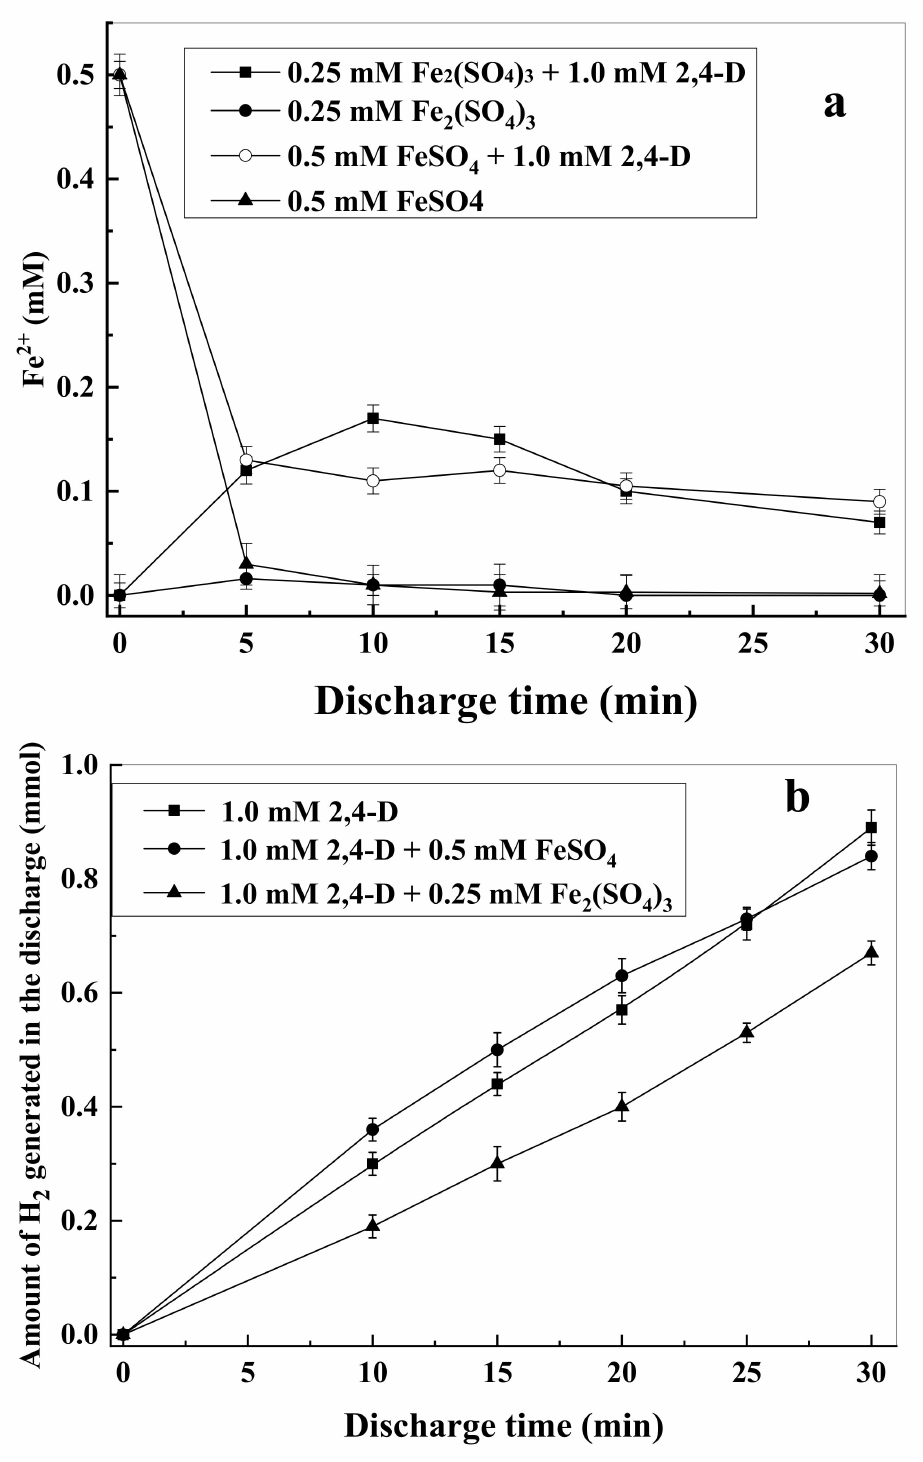
Figure 7. Formations of Fe 2+ ( a ) and H 2 ( b ) during RFD (input power, 200 W; pH 0 ,